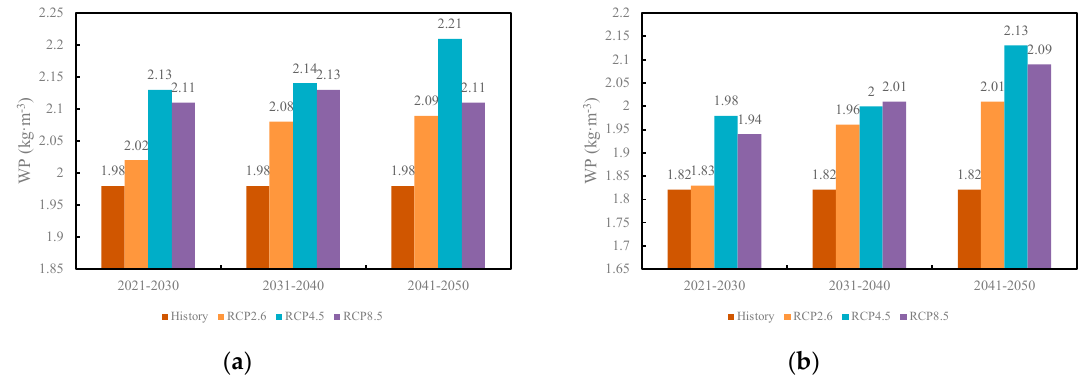
Figure 9. Decadal changes of the maize WP in the ( a ) Gaotai area and ( b ) Ganzhou area under the three RCP scenarios.